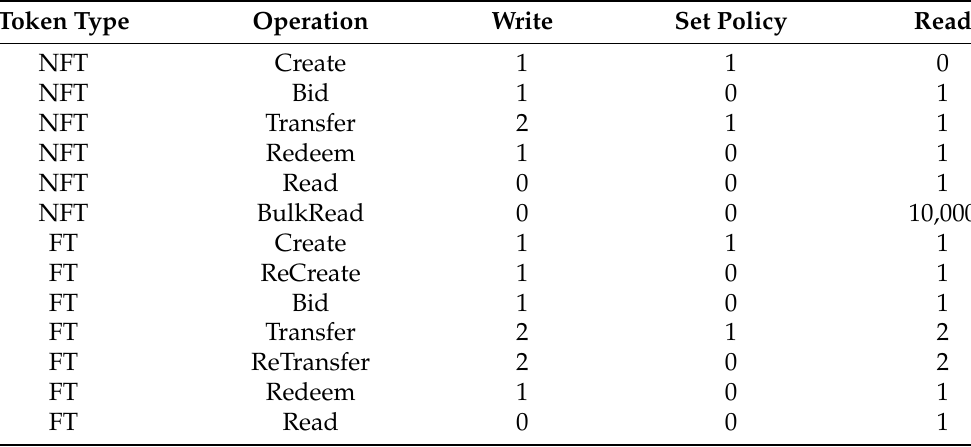
Table 3. Summary of key operations involved in each operation for experimental evaluations.